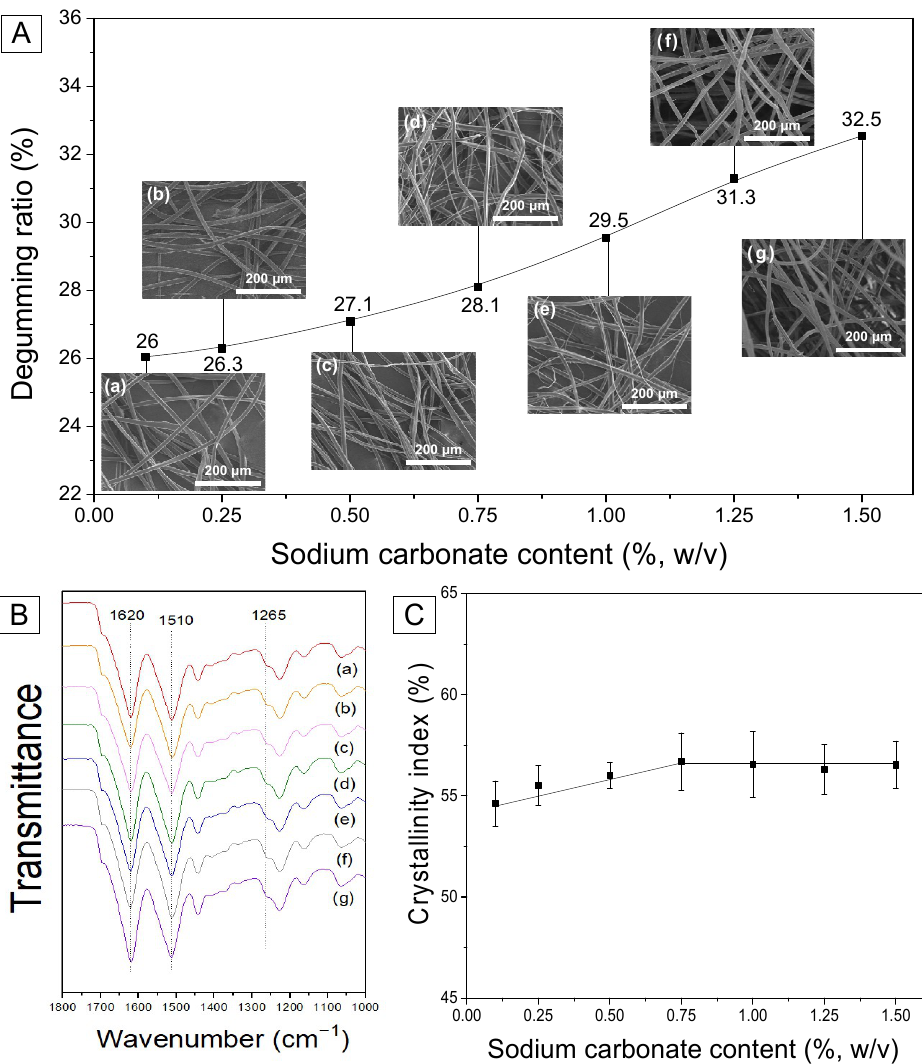
Figure 1. ( A ) Degumming ratio and FE-SEM images, ( B ) FTIR spectra, and ( C ) crystallinity index of silk fibers degummed using various sodium carbonate contents ( w / v ); ( a ) 0.1%, ( b ) 0.25%, ( c ) 0.5%, ( d ) 0.75%, ( e ) 1%, ( f ) 1.25% and ( g ) 1.5%.